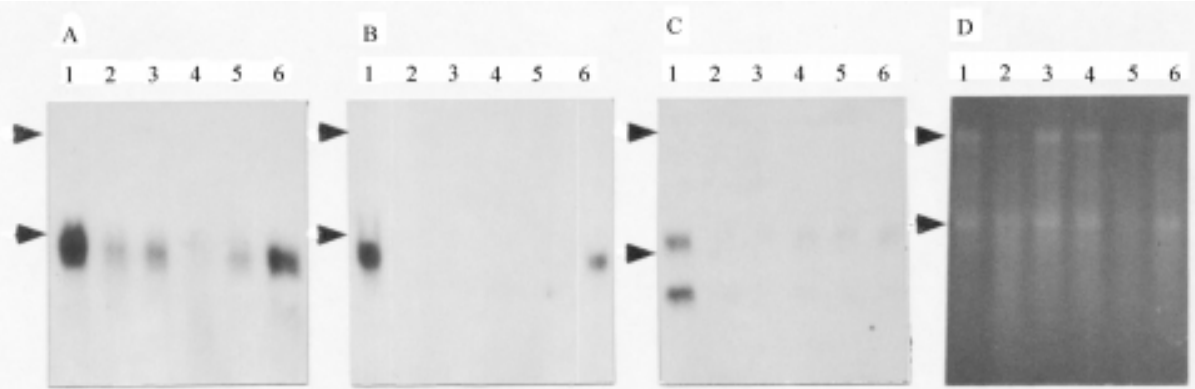
Figure 3 - Northern blot analysis of tortoise RNA in various tissues. Tortoise CaM-A , -B , and -C cDNAs were used as probes in panels A, B, and C, re- spectively, and an EtdBr-stained gel is shown in panel D. Lanes 1-6 represent total RNA isolated from brain, liver, kidney, intestine, heart, and testis, re- spectively. About 5 µ g of total RNA underwent electrophoresis in 1.0% agarose gel. Arrowheads indicate the positions of the major ribosomal RNA bands of the Japanese